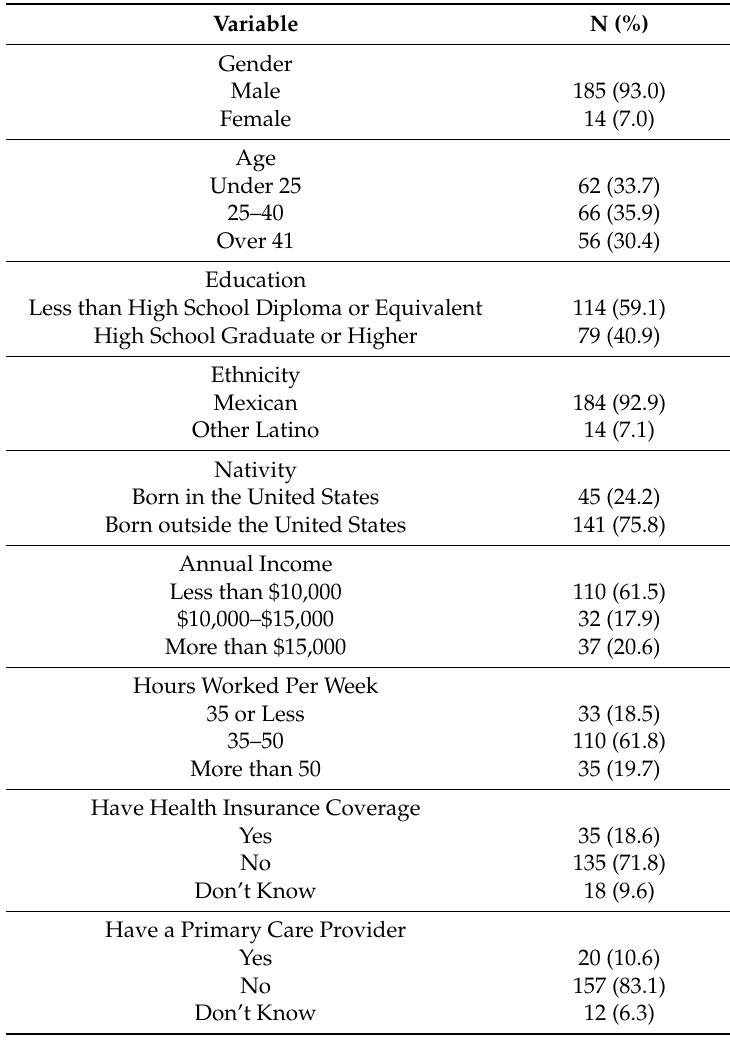
Table 1. Demographic Characteristics of